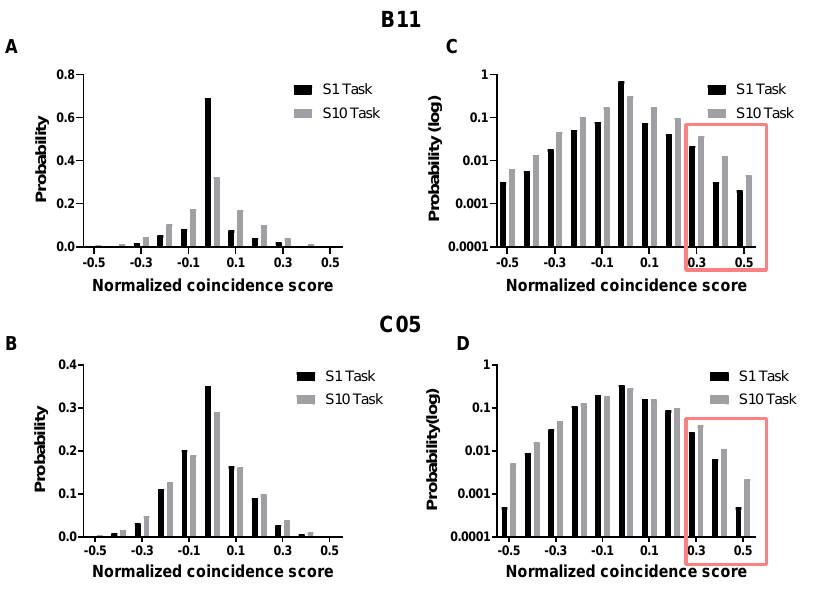
Figure 4. The stronger modulation of NCS in the last session of learning indicates that reproducible neural patterns were generated. ( A , B ) The NCS distribution of the task block in the first session (S1) compared to the last session (S10). ( C , D ) Distribution on the right side of the panel was shown in the y-axis, logarithmically scaled to better reveal the growing frequency of high NCS, especially the range over the NCS threshold (i.e., 0.3–0.5), as indicated by the red box.